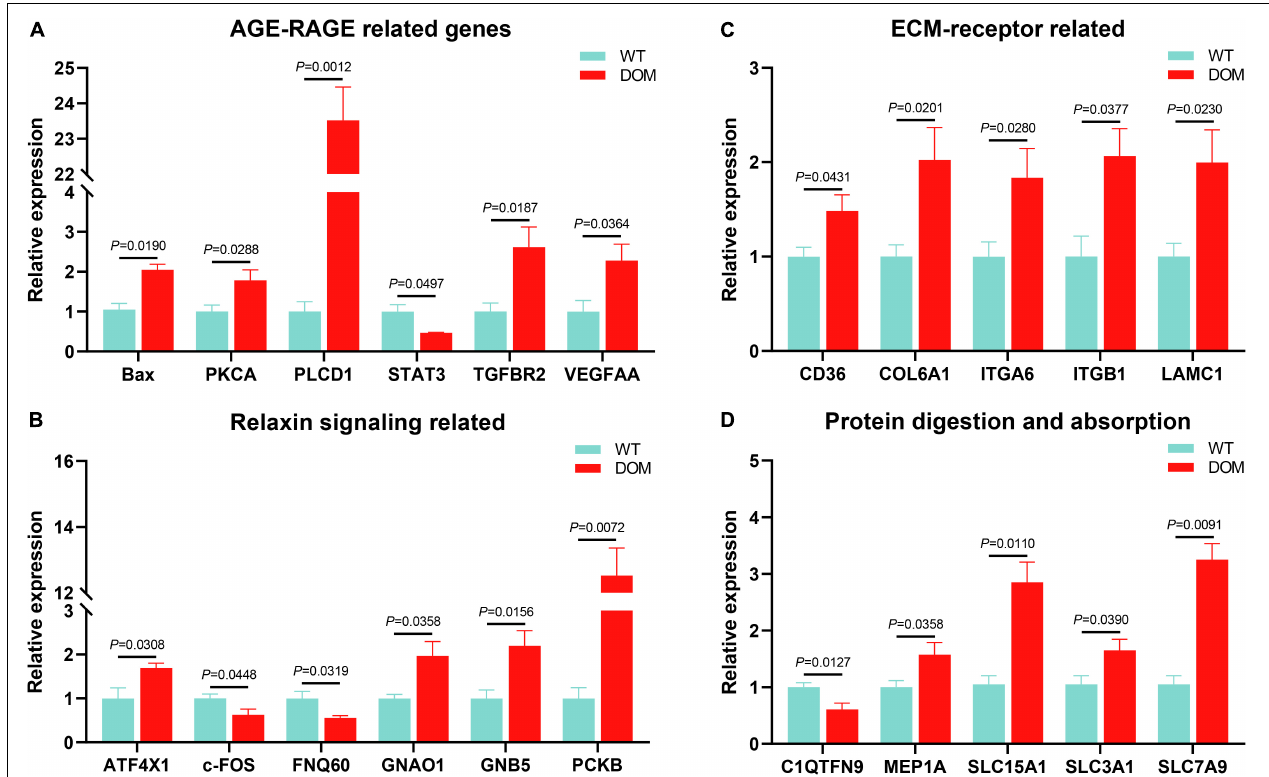
FIGURE 8 | Pseudomonas medicated AGE-RAGE, Relaxin, ECM-receptor, and Protein digestion and absorption were active to feed domestication in A. grunniens . Transcriptional expression of AGE-RAGE related (A) , Relaxin signaling related (B) , ECM-receptor related (C) , and protein digestion and absorption related (D) genes. Data were analyzed by Students’ t -test, results were indicated as mean ± SEM, n =